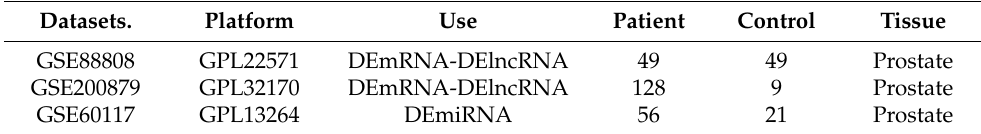
Table 1. Information of datasets.